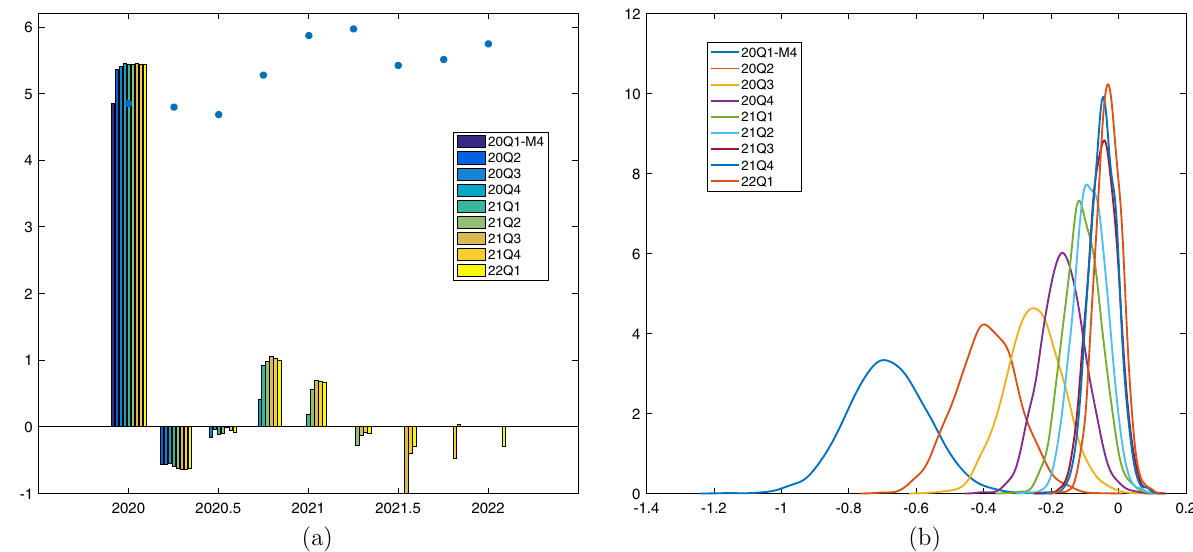
Fig. 4 Log short-time workers. a Mean in-sample one-step ahead forecast error. Expanding sample period: April 2000–March 2020 for forecasting start date F = 20 Q 1- M 4 and April 2000 to quarter’s second month for starting forecast quarter F = 20 Q 2, ... ,22 Q 1 . The dots represent cumulated shocks up to forecasting start date (the sum across equally colored bars). b Posterior distribution of θ . Sample period: First quarter 2000 + max ( p , m ) to fourth quarter